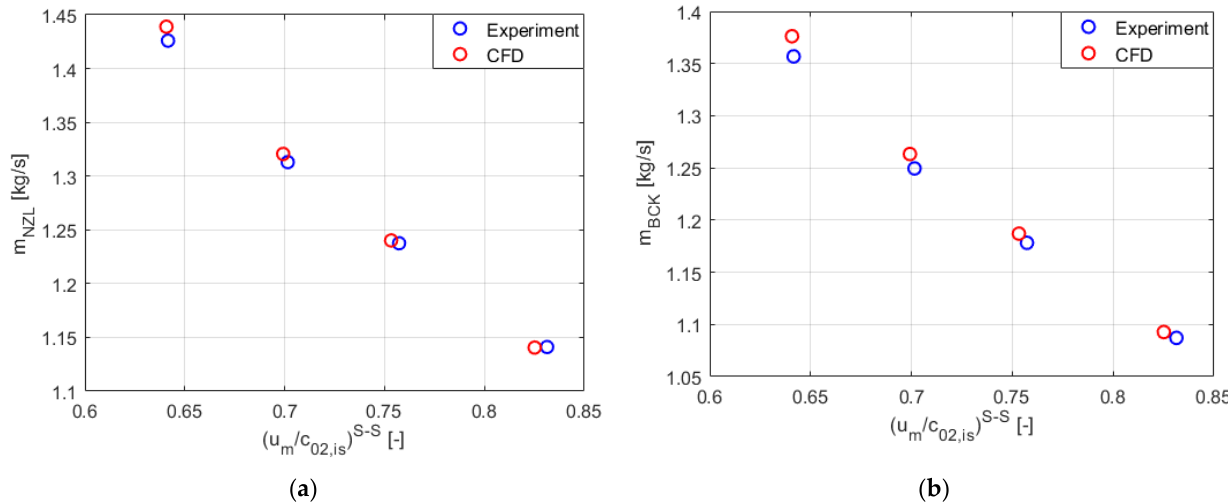
Figure 7. Comparison of mass flow rates of: ( a ) nozzle; and ( b ) bucket.